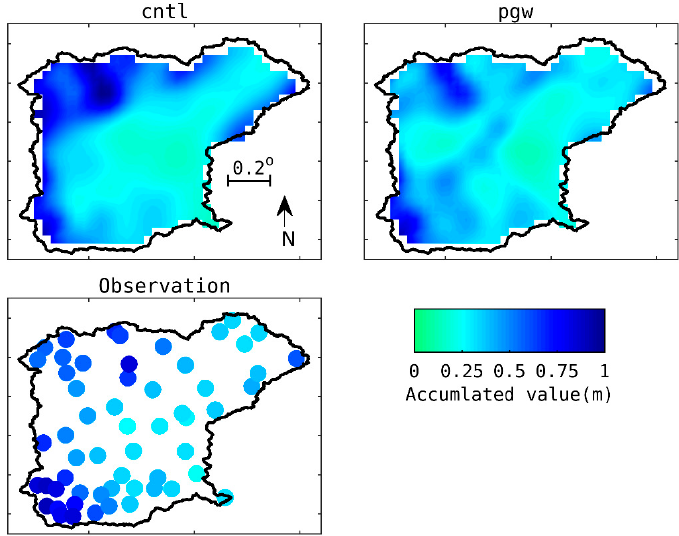
Figure 2. Accumulated distributions of the precipitation during the August 2016 disaster. “cntl”, “pgw”, and “observation” indicate reproductions of the current climate, future climate, and real world observed data at rain-gauge stations, respectively.